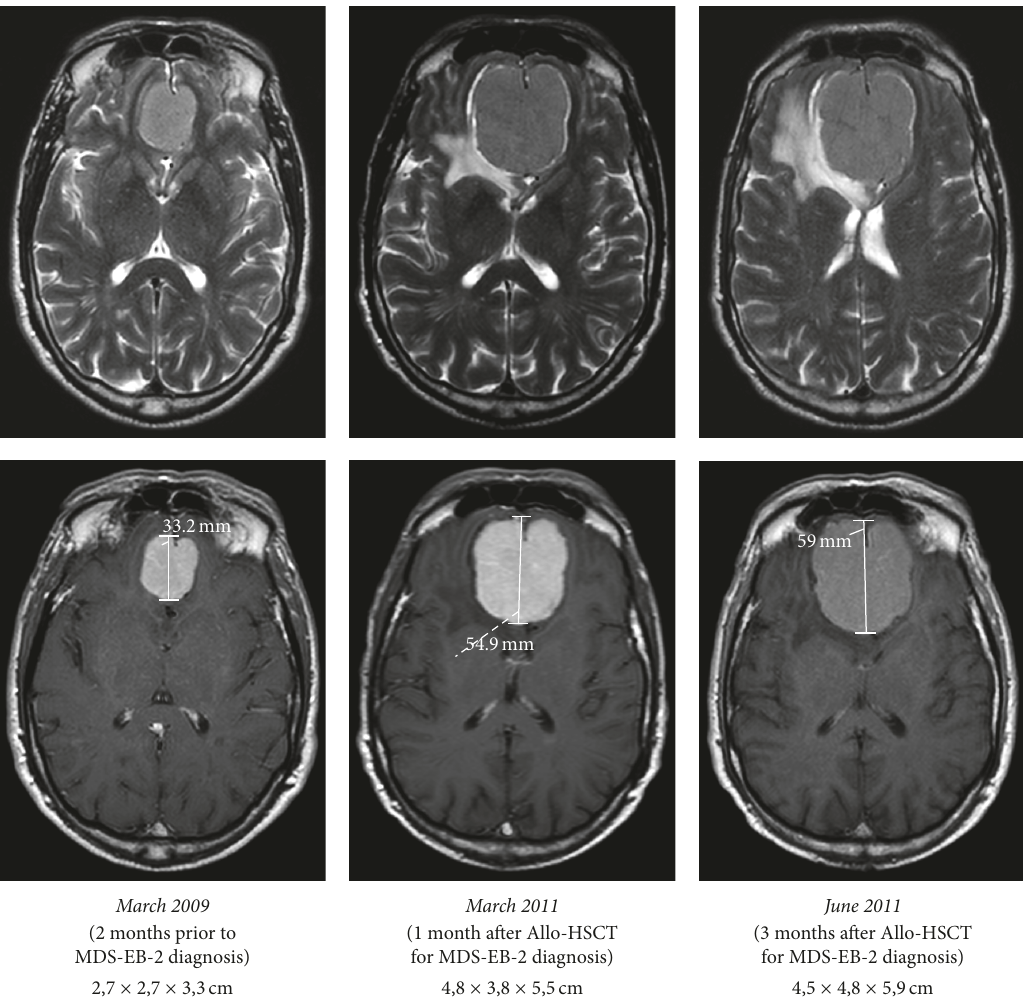
Figure 1: Meningioma-like tumor evolution since diagnosis until patient